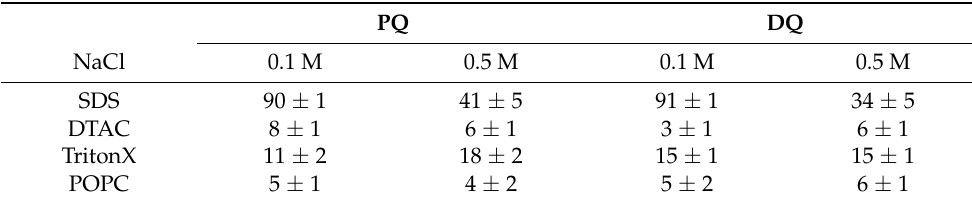
Table 2. Retention percentage (R%) of the analyzed herbicides on micelles and liposomes (NaCac 2.5 mM, pH 7.0, 25.0 ◦ C, C SDS = C DTAC = C TritonX = 0.01 M, C POPC = 5 × 10 − 6 M). Tests were performed in triplicate, errors are ±